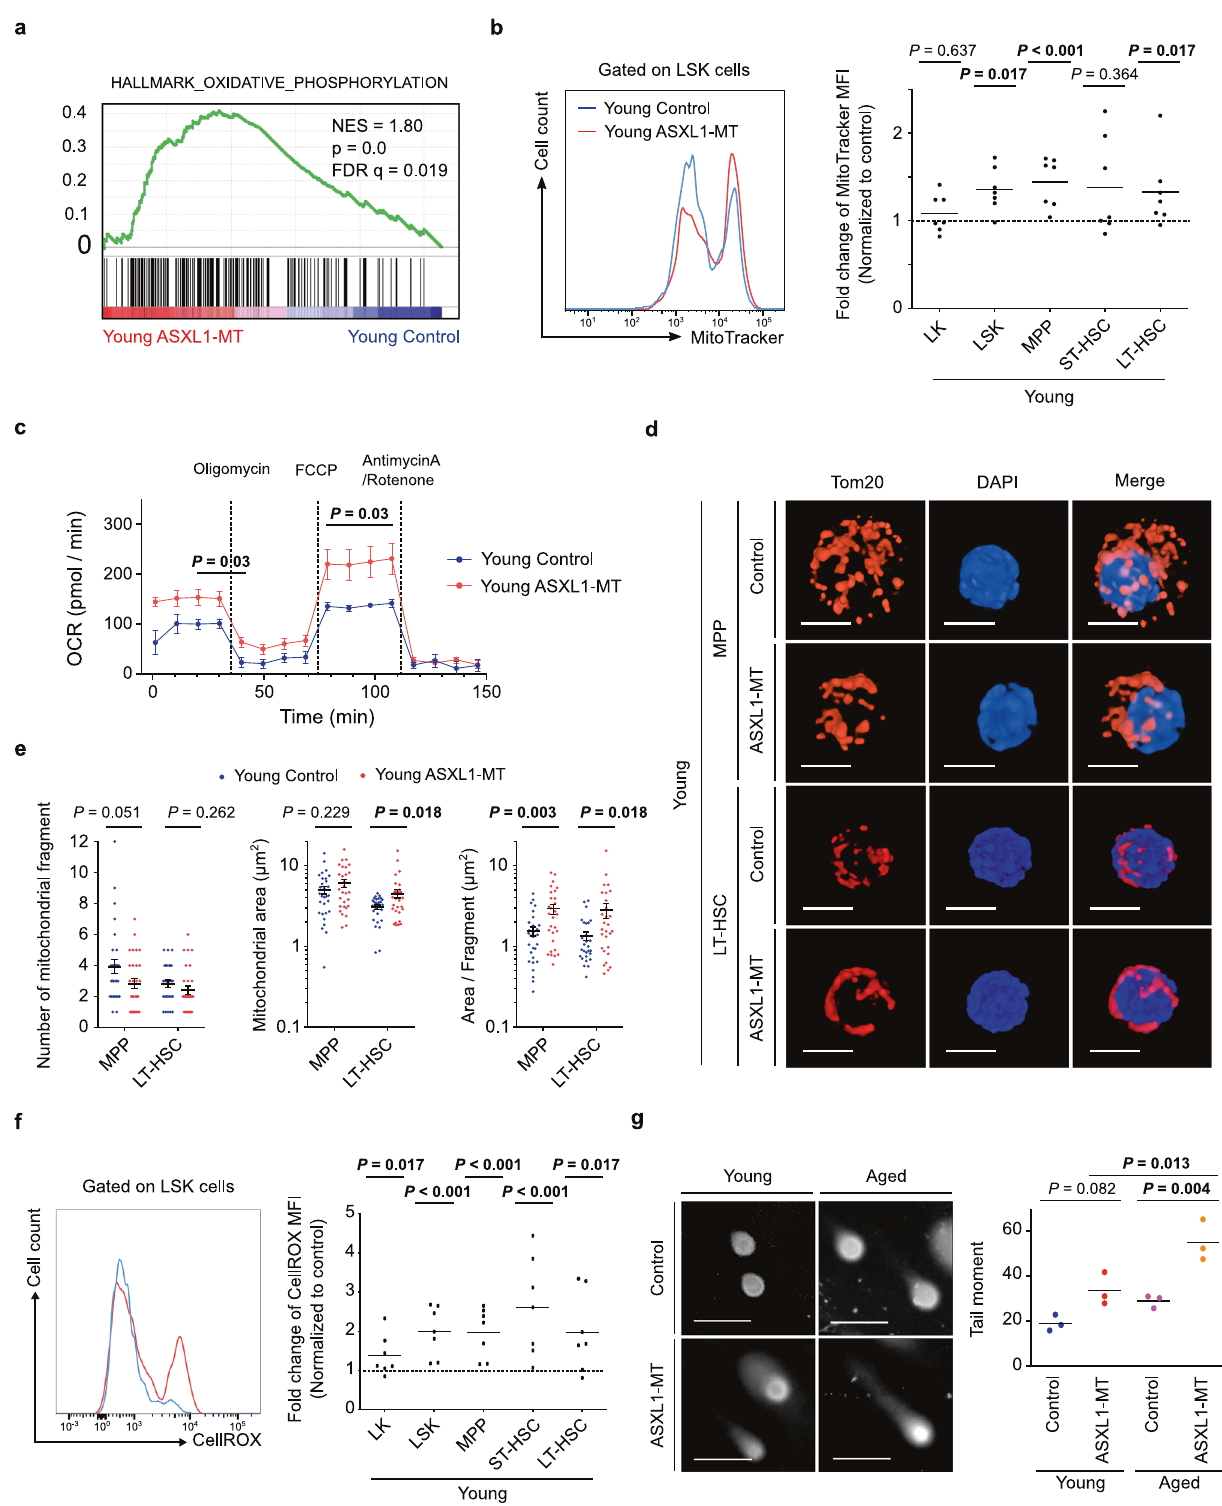
15 min at room temperature. Cells were then incubated with anti-p-H2A.X (Cell Signaling Technology, #9718, 1:200), anti-Akt (Pan) (Cell Signaling Technology, #4691, 1:400), anti-Phospho-Akt (Ser473) (Cell signaling Technology, #4060, 1:400), anti-pS6 (Ser235/236) (Cell Signaling Technology, #4858, 1:100), or isotype control (abcam, ab172730) antibody for 1 h at room temperature, respectively. Cells were then washed and incubated with Alexa Fluor 647 goat anti-rabbit IgG (Invitrogen, A21245, 1:2000) for 1h at room temperature.